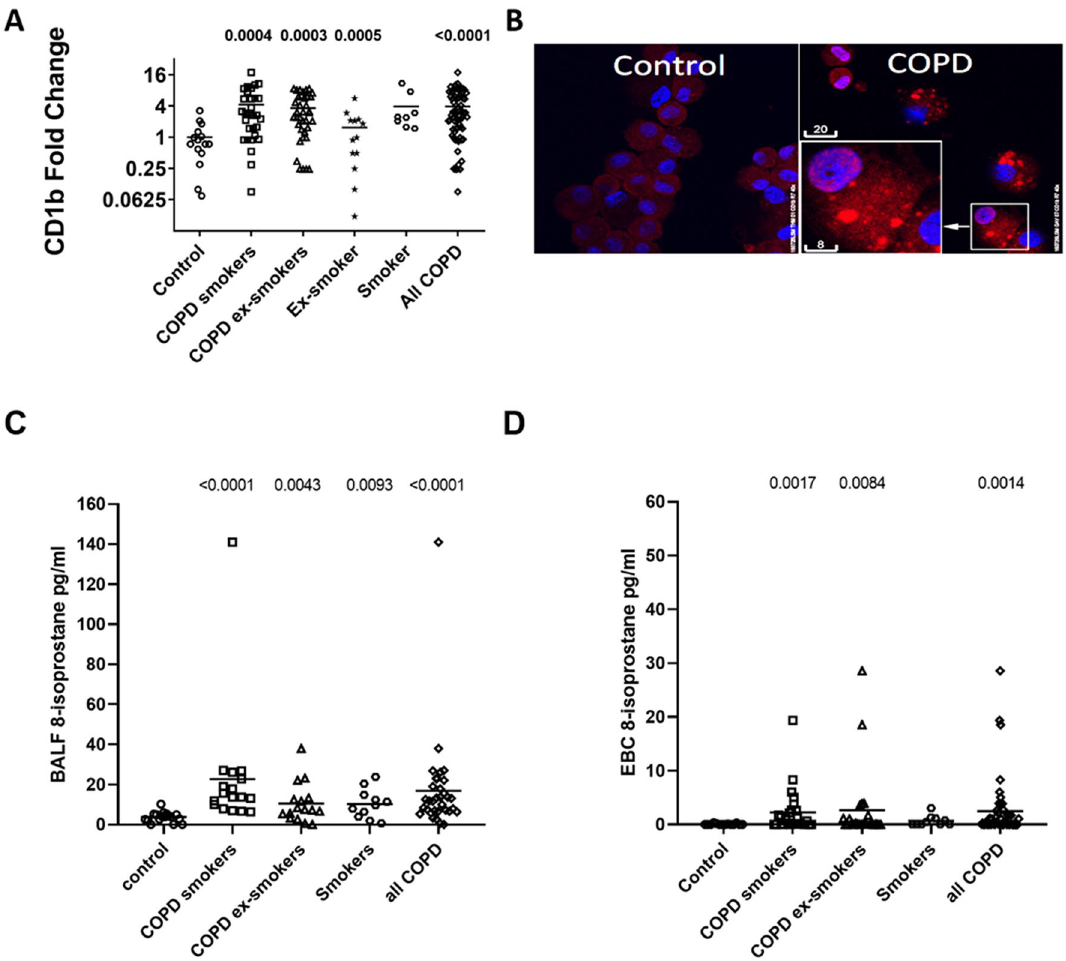
Figure 2. CD1b expression in alveolar macrophages and 8-isporostane in the airways of COPD patients and smoker s. ( A ) CD1b expression was assessed by flow cytometry using a FITC-conjugated antibody in alveolar macrophages from never-smoker controls (n = 14), ex-smokers (n = 12), current smokers (n = 7), and current- and ex-smoker COPD subjects (n = 29 and n = 36 respectively). Data presented as fold change relative to mean of never-smoker controls. p values vs control provided from Mann Whitney U test. ( B ) Representative confocal images showing increased CD1b (red) in alveolar macrophages from a COPD subject vs. never-smoker control. DAPI (blue); scale bar (μm). 8-isoprostane in ( C ) BALF from never-smoker controls (n = 16), current smokers (n = 11), and current- and ex-smoker COPD subjects (n = 16 and n = 15, respectively) and ( D ) EBC from never- smoker controls (n = 13), current smokers (n = 10), and current- and ex-smoker COPD subjects (n = 24 and n = 23, respectively). Data represents individual values and the mean. Significance from control at p < 0.05. Mann Whitney U test.